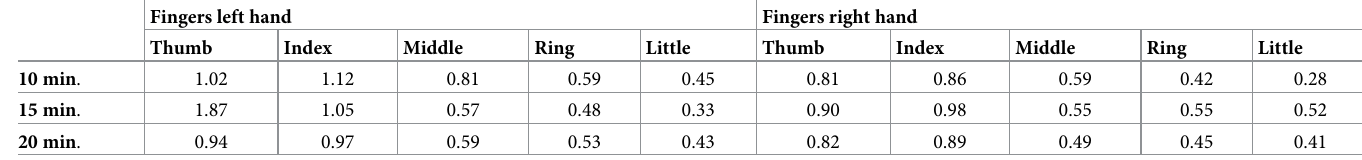
Table 5. Temperature differences (˚C) of the dorsal part of the hand. Fingers left hand Fingers right hand